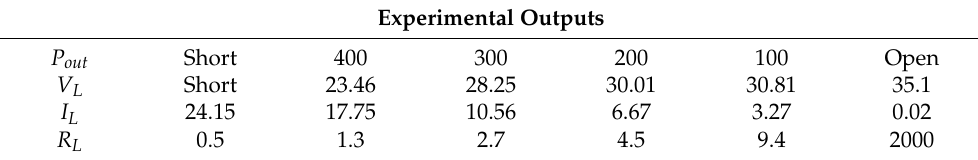
Table 3. Practical parameters of the SS topology with conventional design for